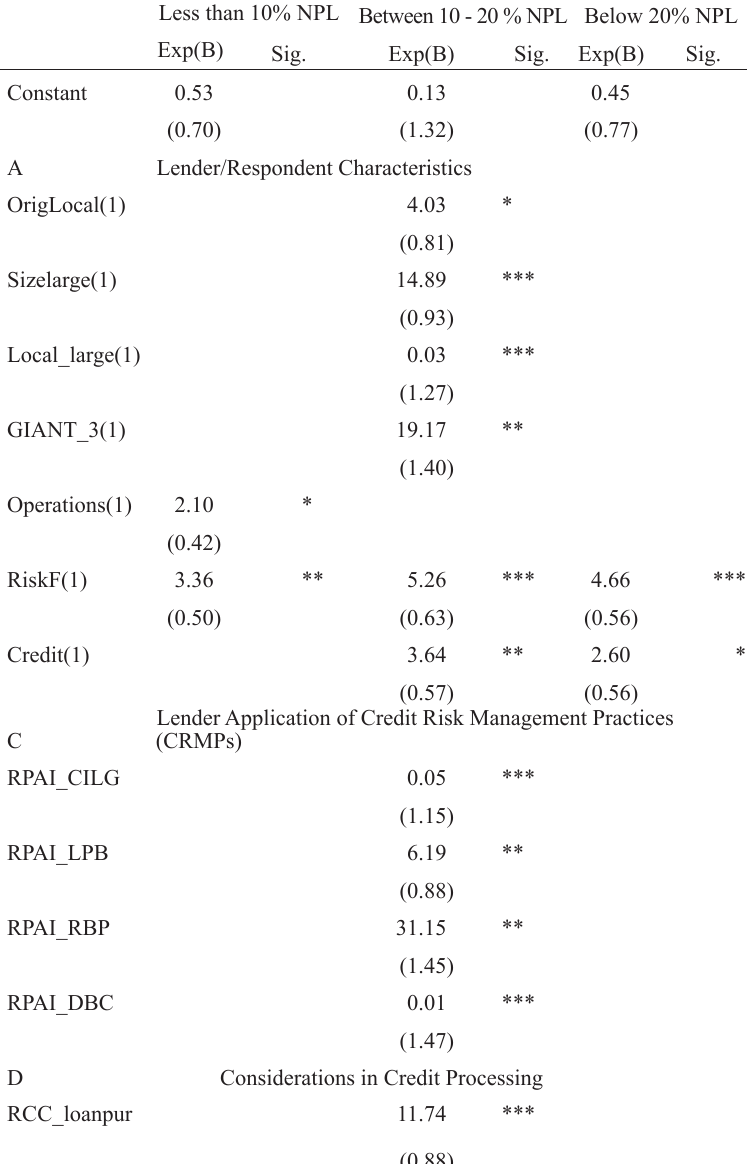
Binary Logistic Model Results from Determinants of “LOW”